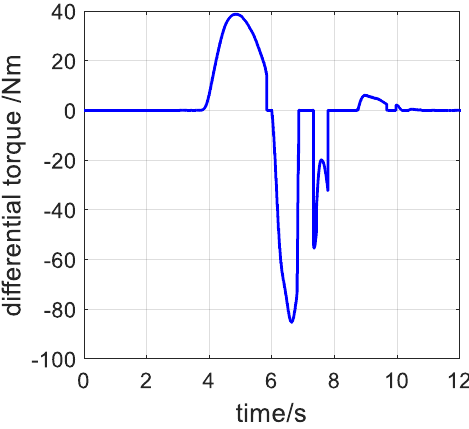
Figure 13. Differential torque.